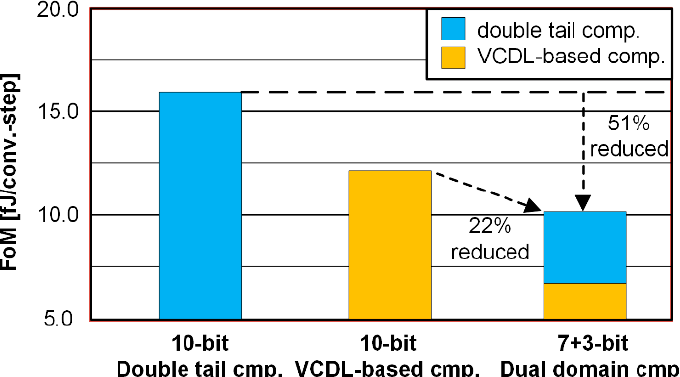
Figure 10. Simulated FoM according to comparator types.